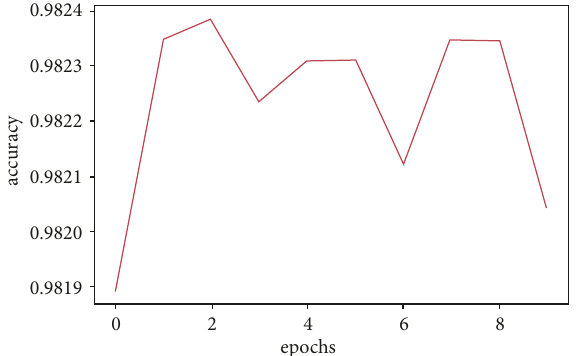
Figure 12: CNN model two accuracy fluctuation.